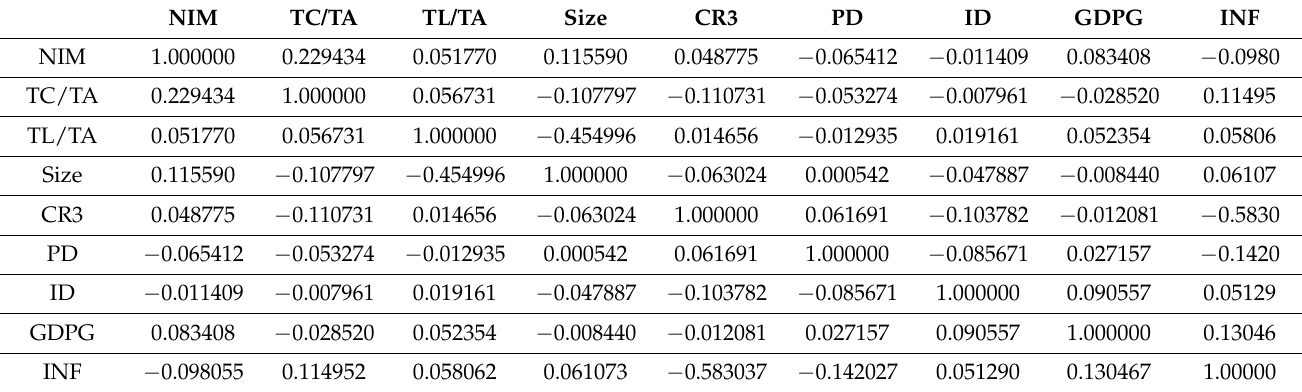
Table A3. Correlation matrix for the NIM